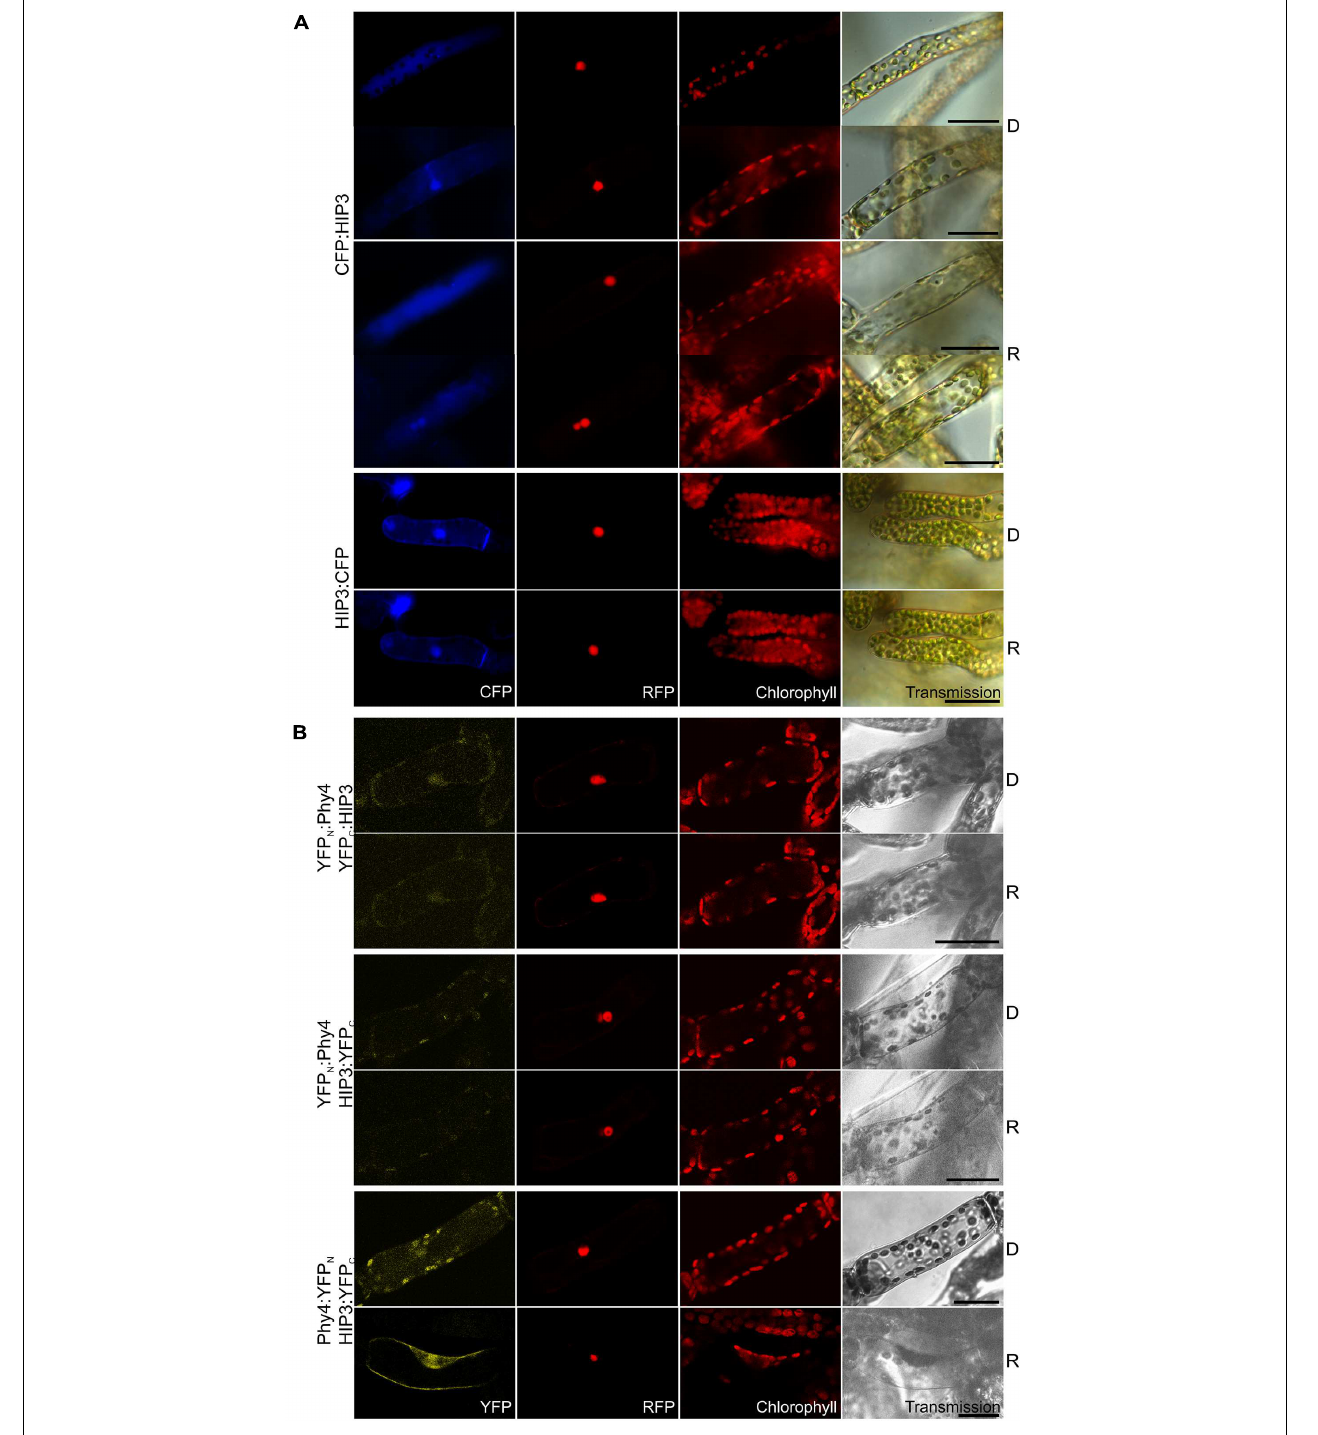
FIGURE 2 | HIP3 (Pp3c10_4820V1.1) intracellular localization (A) and split-YFP-studies of HIP3–phy4 interaction (B) each without (D) and with red pre-treatment (R) using fluorescence- and confocal microscopy, respectively. Overall figure structure is analogous to Figure 1 . (A) CFP:HIP3 (rows 1–4) and HIP3:CFP (rows 5 and 6). CFP:HIP3 localization was ambiguous, being observable either in the nucleus and cytoplasm (rows 2 and 4) or in the cytoplasm only (rows 1 and 3) in both conditions, whereas HIP3:CFP showed nuclear and cytoplasmic localization (column 1, CFP). (B) Split-YFP analyses of YFP N :phy4–YFP C :HIP3 (rows 1 and 2), YFP N :phy4–HIP3:YFP C (rows 3 and 4) and phy4:YFP N –HIP3:YFP C (rows 5 and 6) configurations. Significant nucleo-cytoplasmic signals were only seen for phy4:YFP N –HIP3:YFP C after R pre-treatment (column 1, YFP; D and R here from separate experiments). All other configurations/conditions yielded only background signals alongside channel bleed-through. Scale bars 30 µ